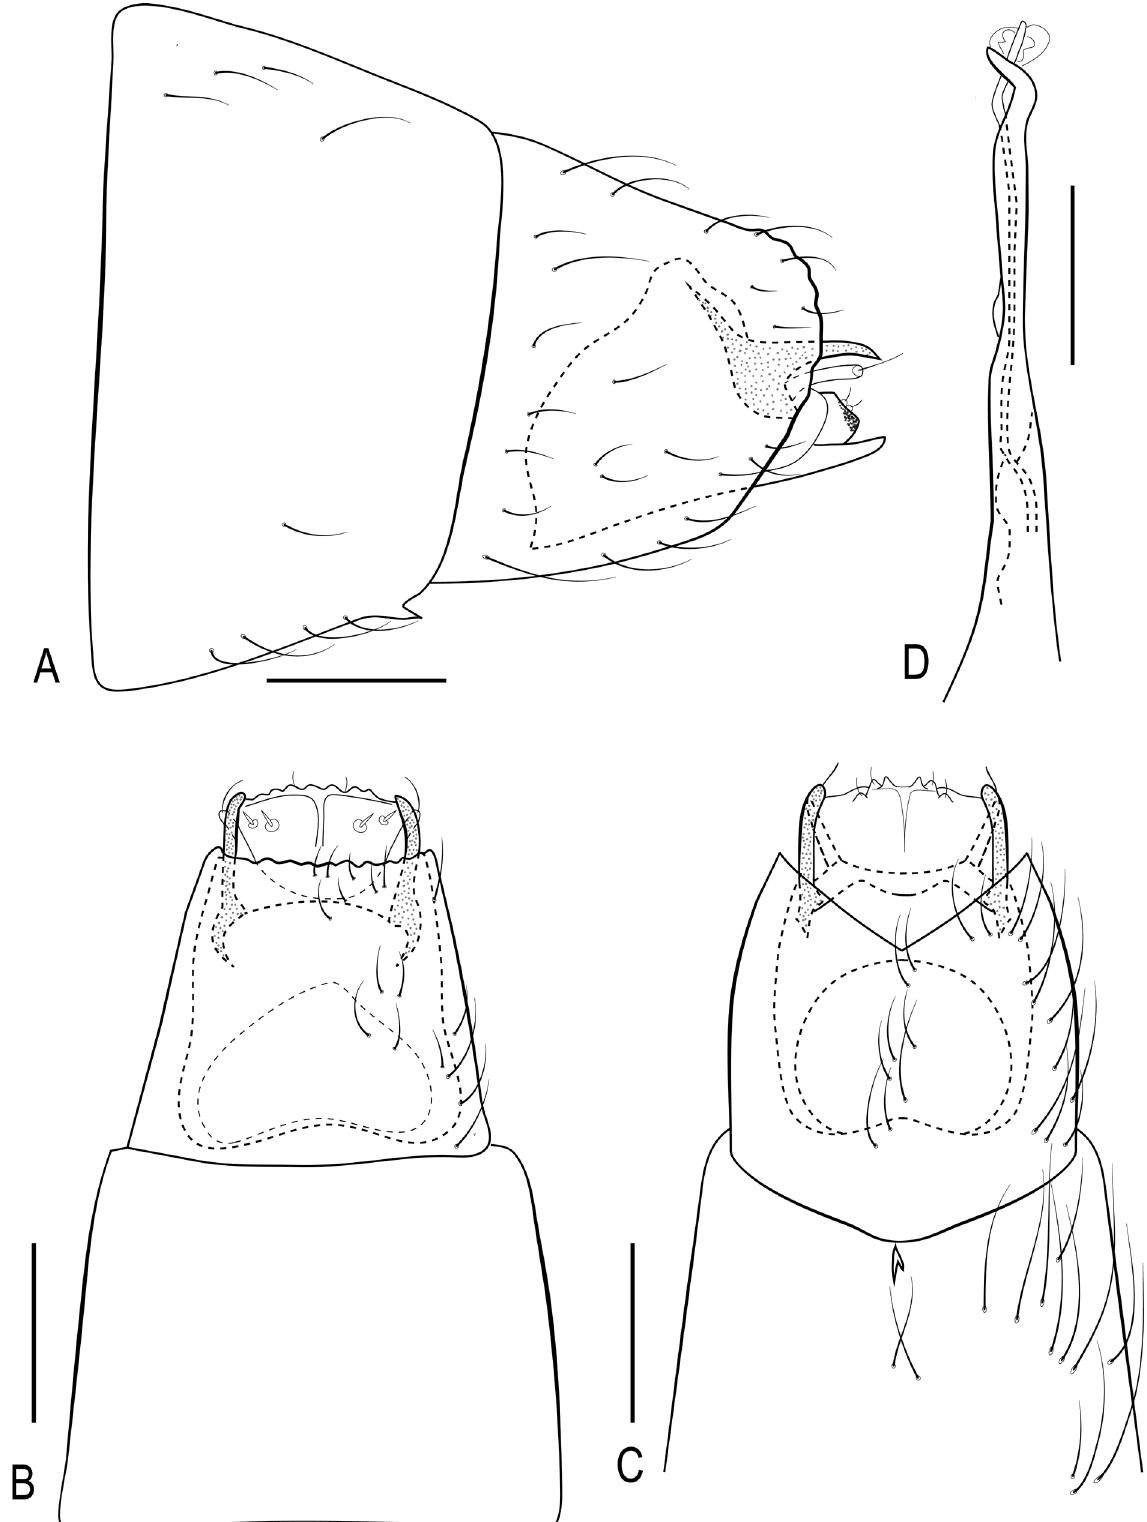
Fig. 2. Oxyethira ( Trichoglene ) rectangulata sp. nov., male genitalia. A . Lateral. B . Dorsal. C . Ventral. D . Aedeagus, dorsal. Scale bars = 0.1